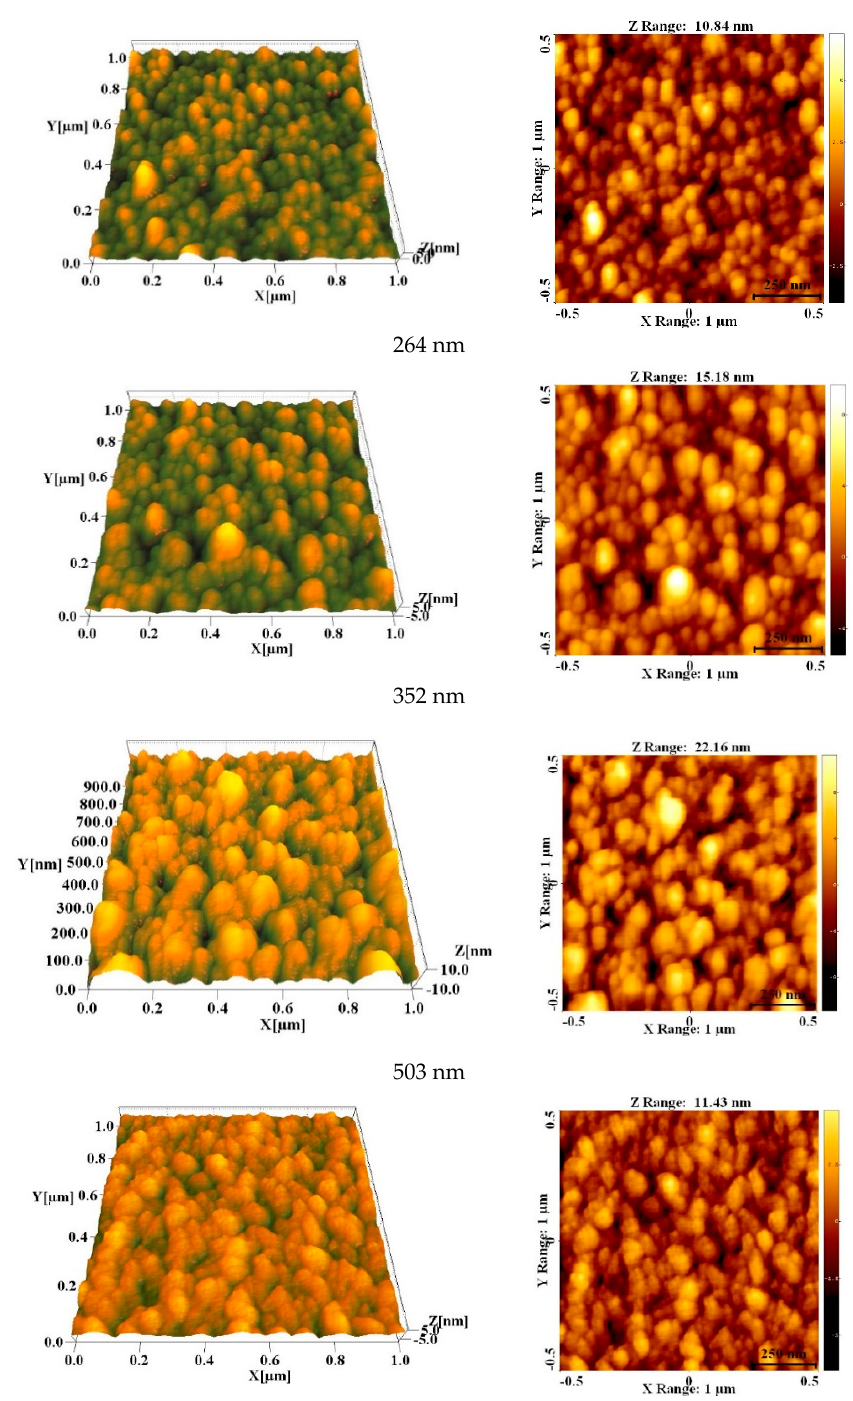
Figure 3. 2D and 3D AFM of NiO x thin films at di ff erent film thicknesses.